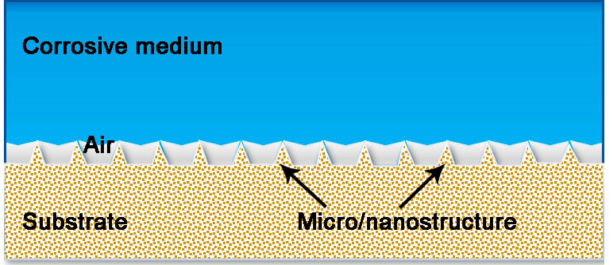
Figure 2. Schematic image of anti-corrosion using a super-hydrophobic surface. The super-hydrophobic micro / nanostructures keep surface wettability in ‘Cassie State’ to prevent corrosive medium penetrating the air layer and contacting with the